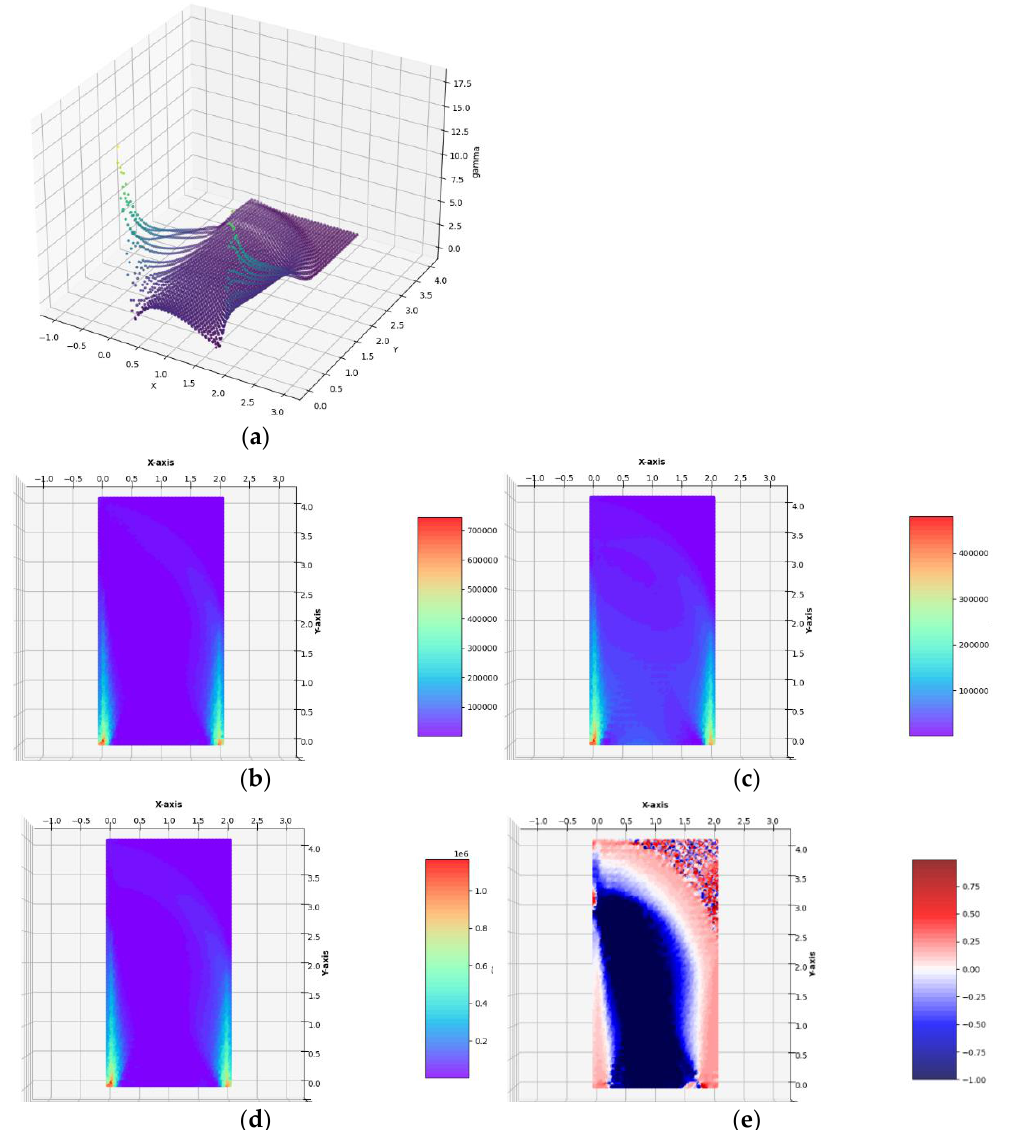
Figure 7. Optimal solutions of the problem of Example 1a. ( a ) The plot of the γ function, ( b ) bulk modulus k * / b , ( c ) shear modulus µ * / b , ( d ) Young’s modulus E * / b , ( e ) Poisson’s ratio ν * in the case of FEM mesh composed of triangular elements.